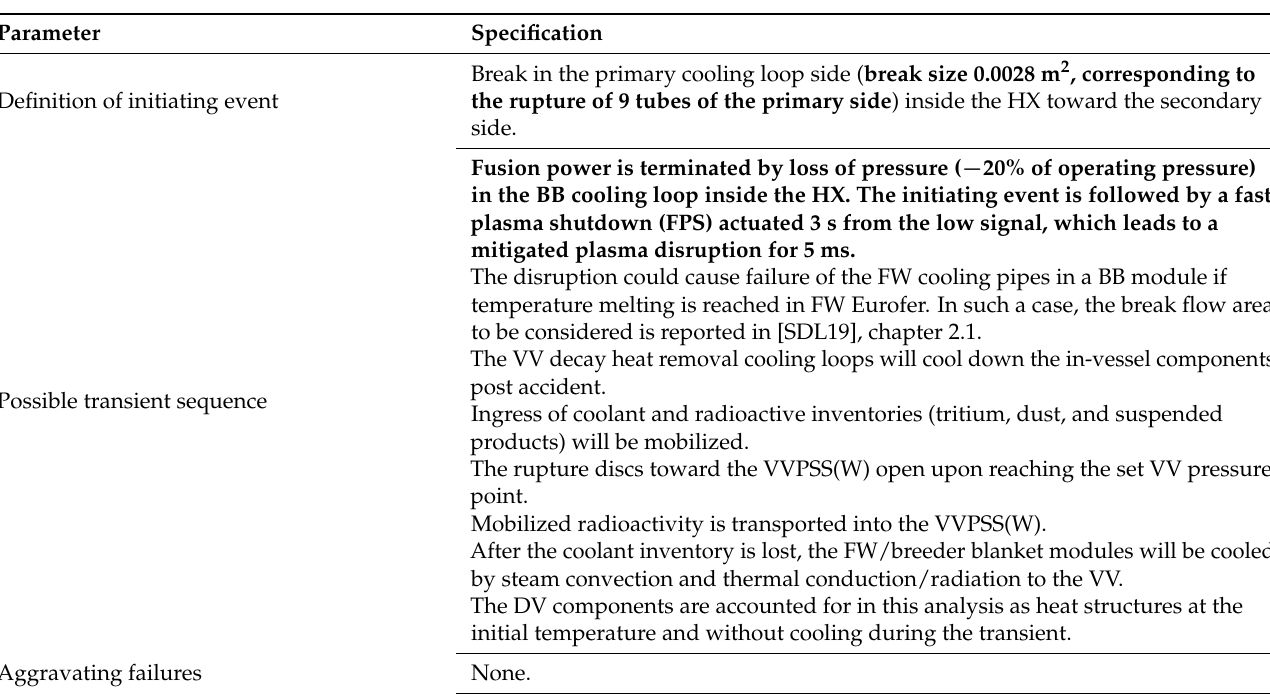
Table 8. Accidental scenario main events sequence.